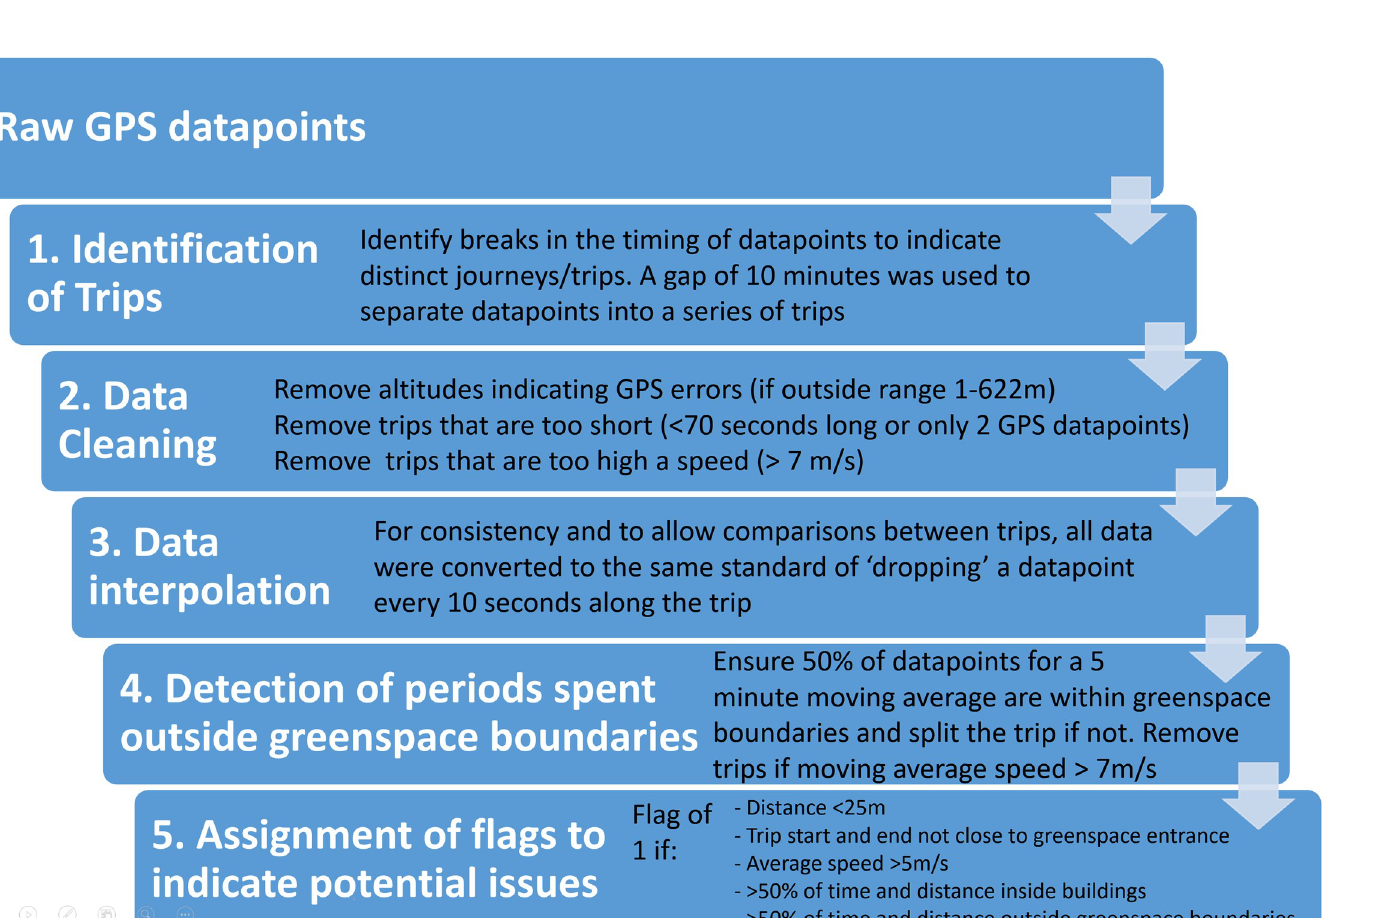
Fig 1. Flowchart summarising the data processing